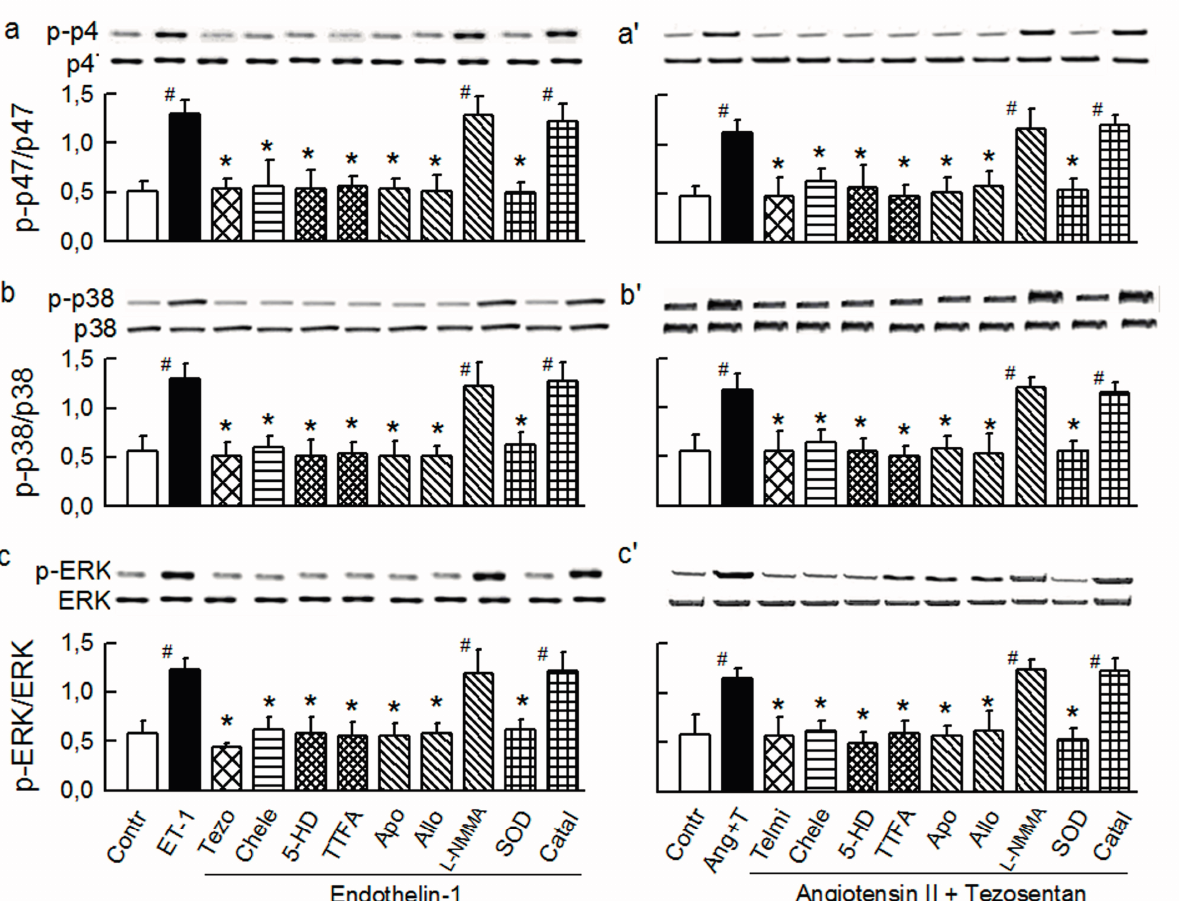
Figure 4. Western blots and densitometry and ratios of phosphorylated and non-phosphorylated proteins: Ser345p47 phox ( a – a' ); p38 MAPK ( b – b' ); and ERK1/2 MAPK ( c – c' ) in guinea-pig hearts stimulated with endothelin-1 (ET-1, 25 pM, a – c ) and angiotensin II (20 nM) combined with tezosentan (5 nM) (Ang-T, a' – c' ). ET-1 and Ang-T were studied either alone or in combination with (from left to right): 5 nM tezosentan (tezo) or 7.5 μ M telmisartan (Telmi), 4 μ M chelerythrine (Chele), 100 μ M 5HD, 5 μ M TTFA, 1 mM apocynin (Apo), 250 μ M allopurinol (Allo), 50 μ M L-NMMA, 150 IU/mL SOD, and 600 U/mL catalase (Catal). Values are means ± SEM of four experiments. # p < 0.05 vs. control; * p < 0.05 vs. ET-1 and Ang-T group,